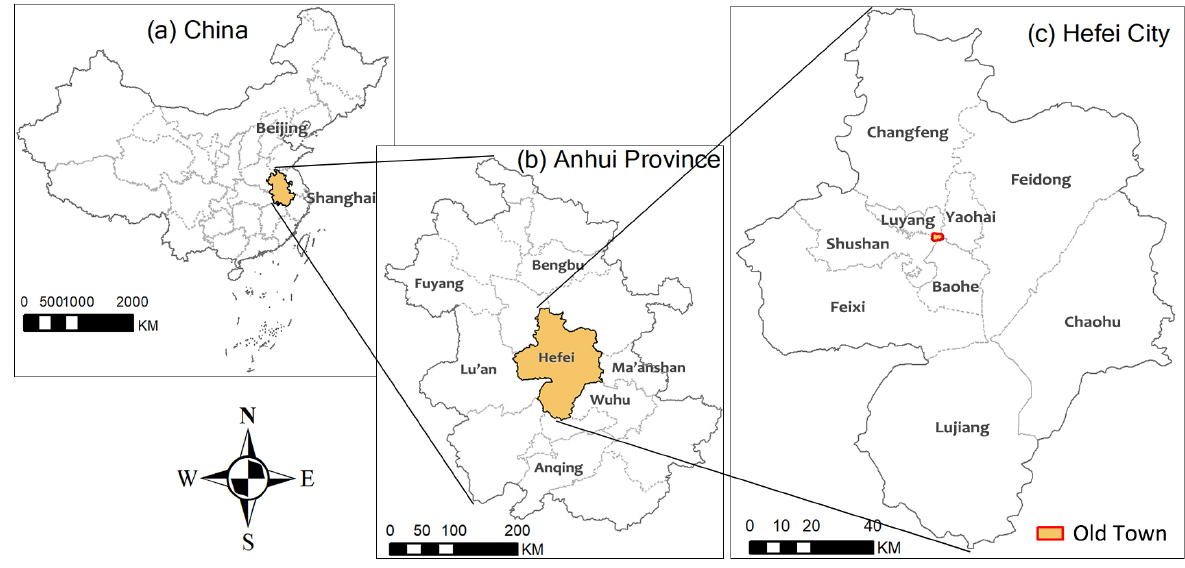
Figure 2. Location of Hefei City and its Old Town (data source: mapbox.com (accessed on 30 March